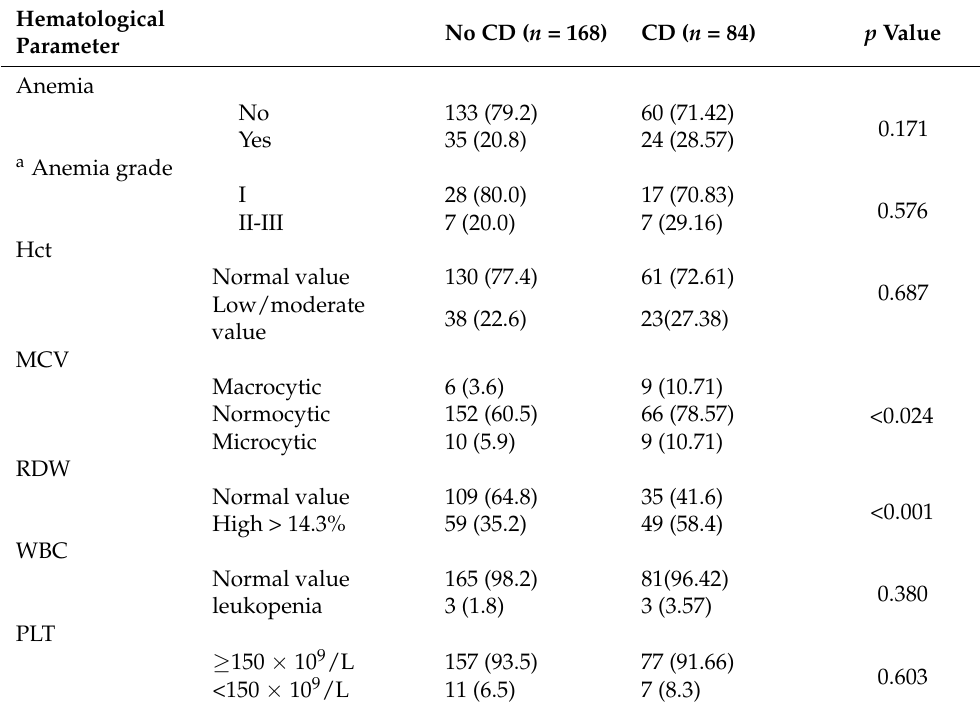
Table 3. Hematological parameters. Comparison between patients without CD and patients newly diagnosed with